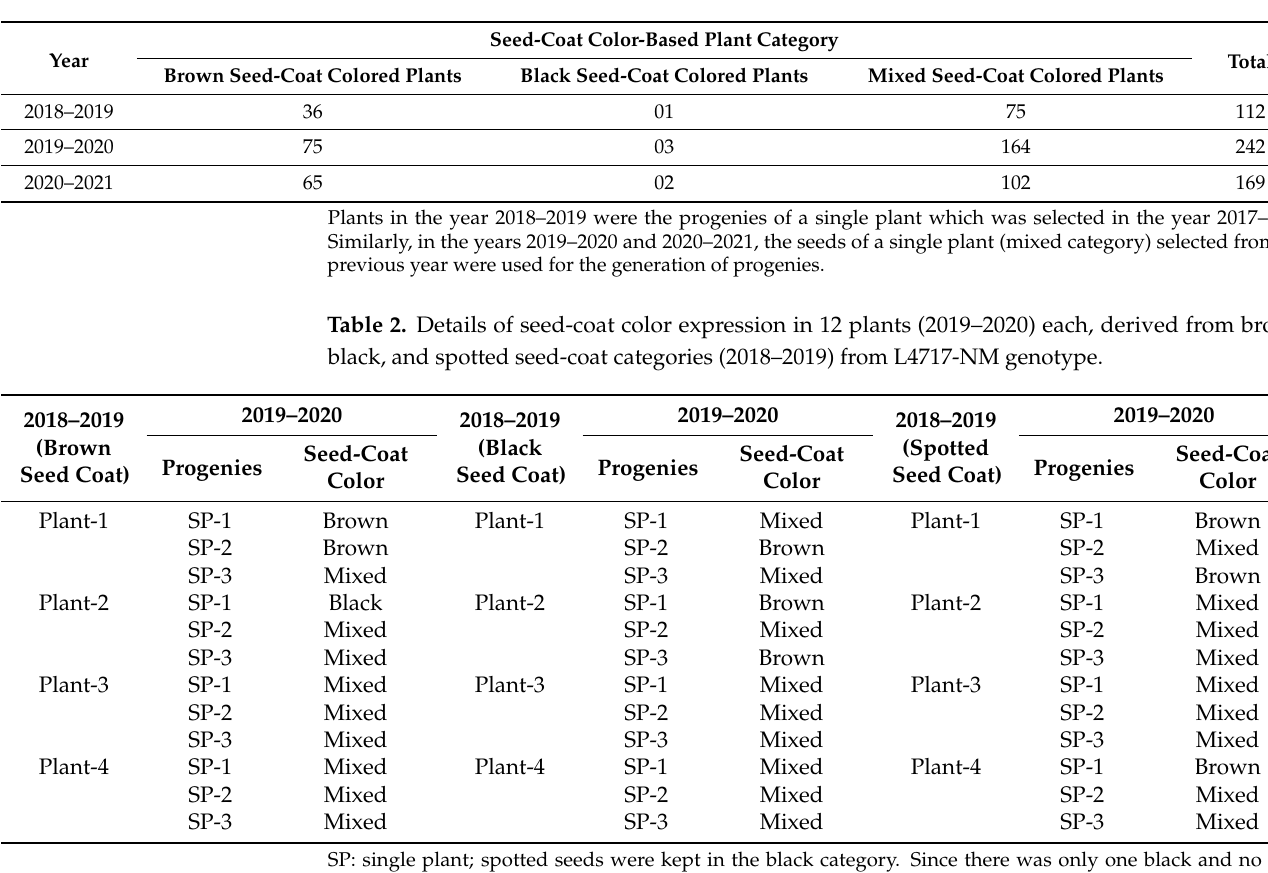
Table 1. Overall categorization of plants in different categories (brown, black, and mixed) based on seed-coat color expression.